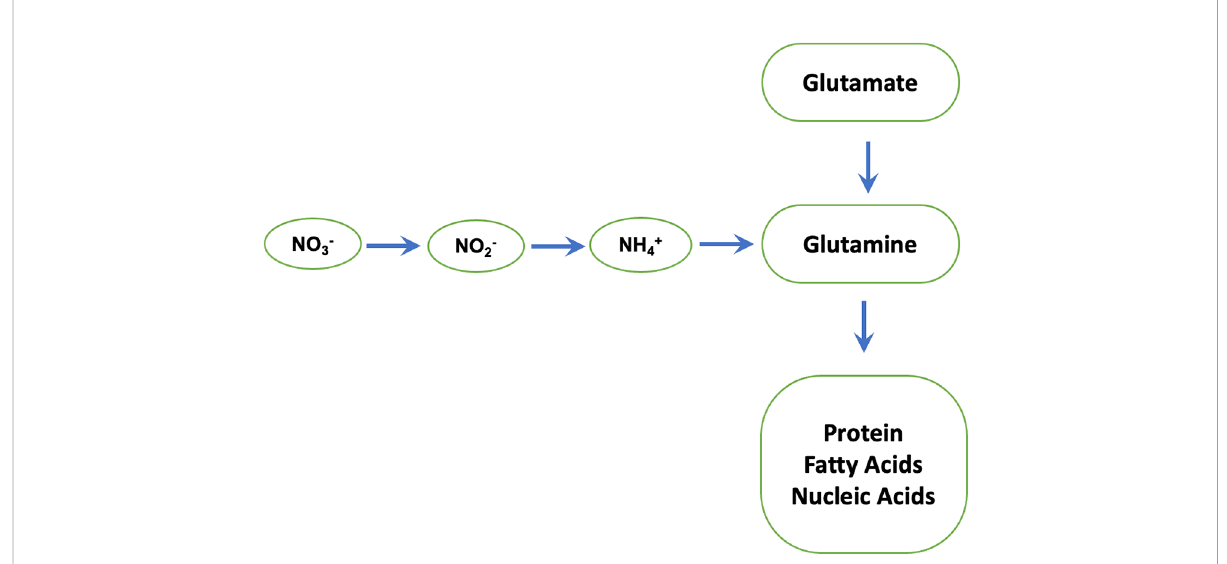
FIGURE 7 Nitrate reductase: a key enzyme in N metabolism. Nitrate reductase catalyses nitrate to nitrite conversion. The nitrite formed is reduced by the enzyme nitrite reductase to ammonium, which then reacts with glutamate to form glutamine by glutamine synthetase. The latter serves as the amino group donor for the synthesis of amino acids, proteins and Nucleic acids.